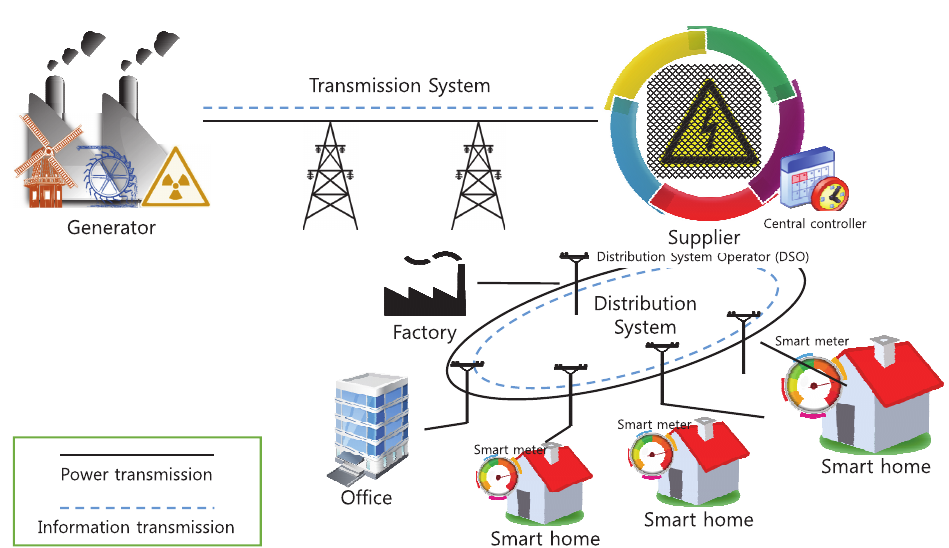
Figure 1. An overview of Smart Grid